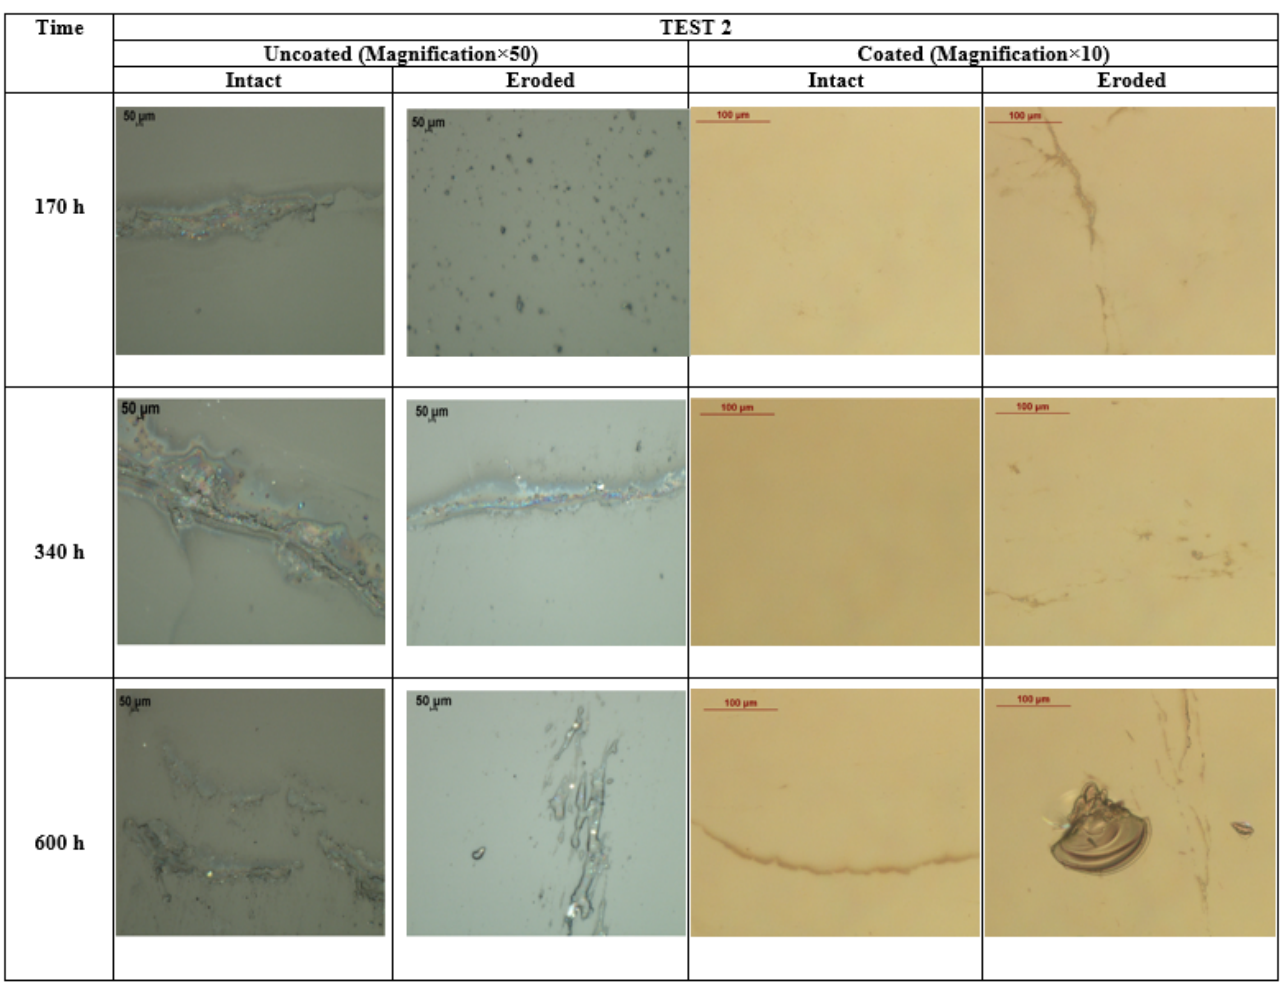
Figure 11. Optical microscope images of tested samples during SUNTEST test N°2 after 170, 340 and 600 h of aging.